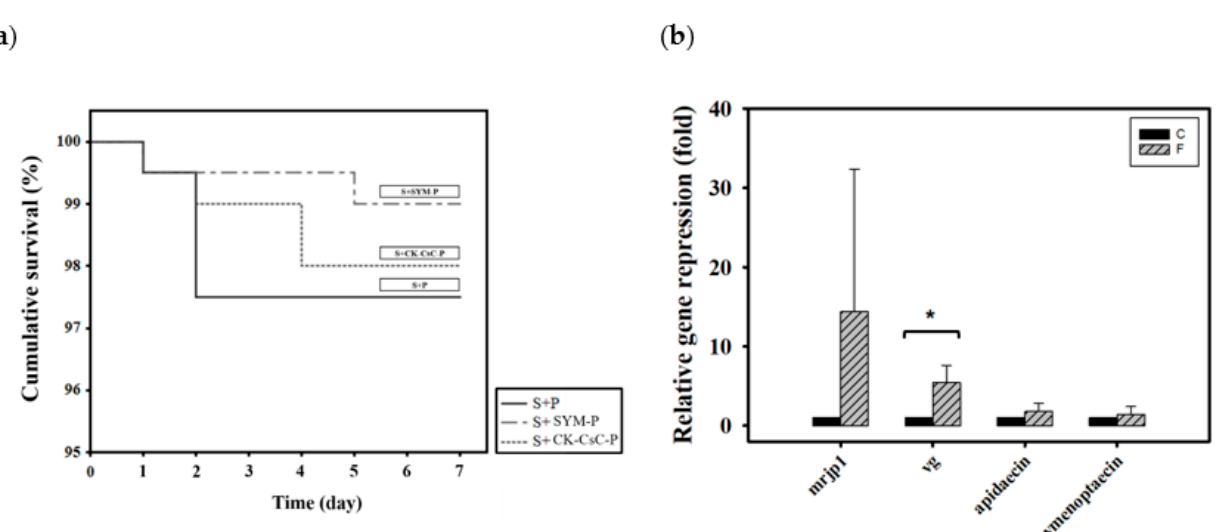
Figure 3. The effect of CK-CsC fermented pollen on honey bees. ( a ) The cumulative survival of honey bees after 6-day feeding treatments. New emerged bees in groups of 50 bees fed with 50% sucrose syrup and bee pollen (S + P), 50% sucrose syrup and bee pollen with addition of SYM broth (S + SYM-P) and 50% sucrose syrup and CK-CsC fermented bee pollen broth (S + CK-CsC-P). Each point represents the cumulative survival rate (N = 4 cages from four colonies). There is no significant difference between survival curves (Log-Rank test: p = 0.524). ( b ) Gene expression profile of honey bees after 6-day feeding treatments. C: control, bees feeding with 50% sucrose syrup and bee pollen with addition of SYM broth; F: bees feeding with 50% sucrose syrup and CK-CsC fermented bee pollen broth. The relative gene expression was analyzed using the 2 −ΔΔ C T method. Data represent the mean of four replicates, with error bars indicating the standard deviation. Bar with the label * is significantly different ( p < 0.05) accordingly to the Mann-Whitney U test.